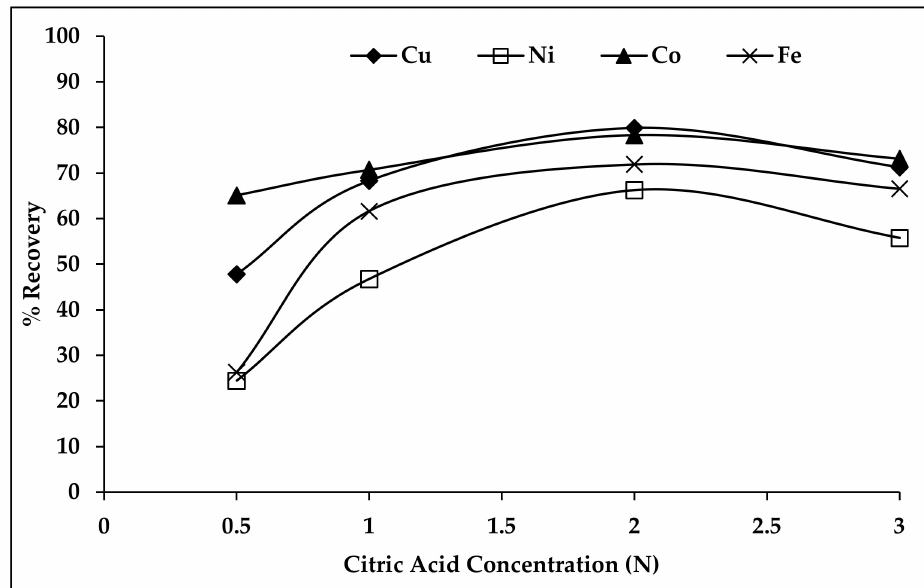
Figure 5. Effect of acid concentration of citric acid on Cu, Ni, Co, and Fe recovery at 5% PD, 308 K in 15 h.